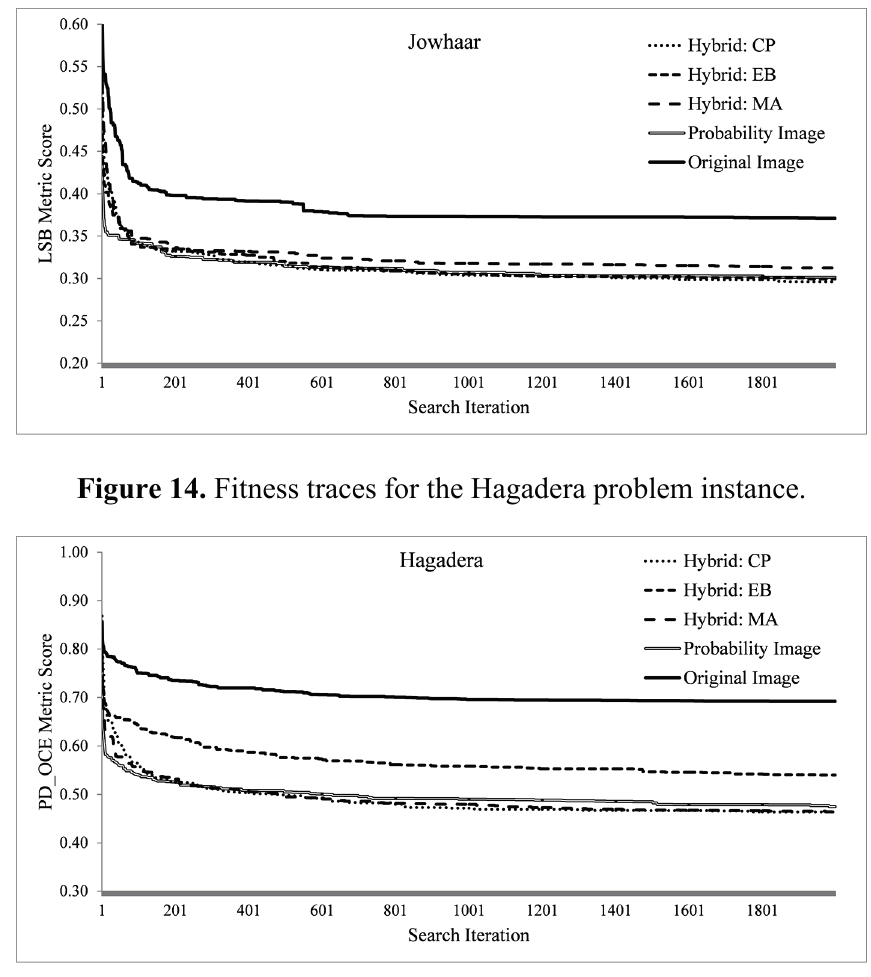
Figure 13. Fitness traces for the Jowhaar problem instance.